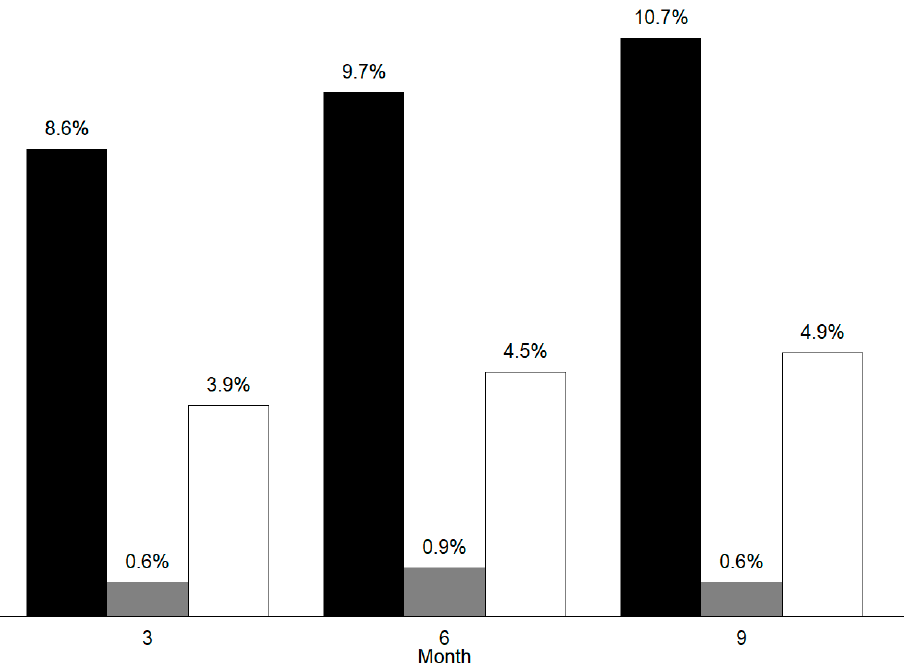
Figure 1. Overall number of percent-based excellent responders to onabotulinumtoxinA (black bars), the overall number of total responders (grey bars) and the overall number of the frequency-based excellent responders (white bars) during the first, second, and third onabotulinumtoxinA cycle.